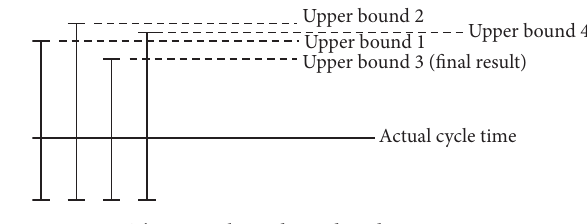
Figure 4: The upper bound is reduced in an iterative